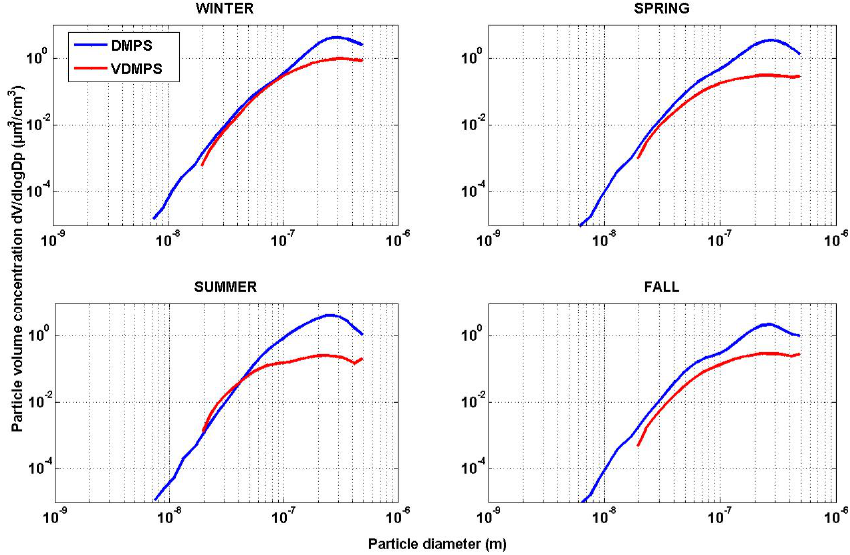
Fig. 4. Seasonal median volume size distributions from DMPS and VDMPS at 280 ◦ C.